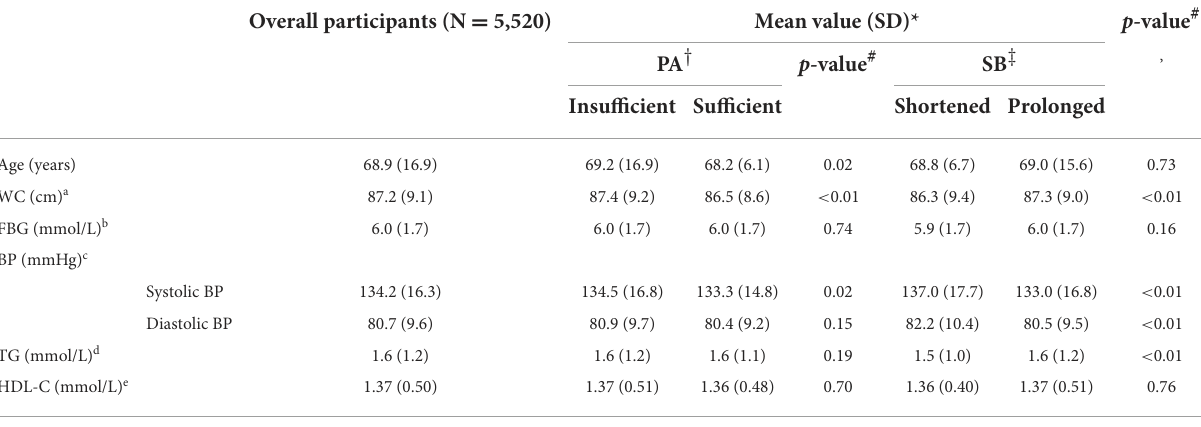
TABLE 3 Distribution of age, WC, FBG, BP, TG and HDL-C by PA and SB among urban men aged 60 + years in regional China. Overall participants (N =